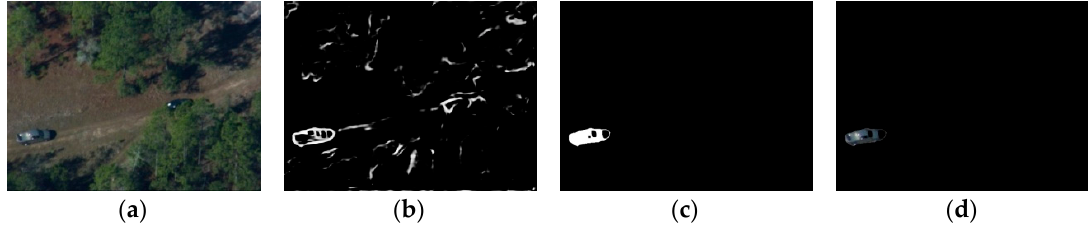
Figure 5. Shape-adaptive template generating process: ( a ) original image; ( b ) contour map; ( c ) target mask; ( d ) target template.